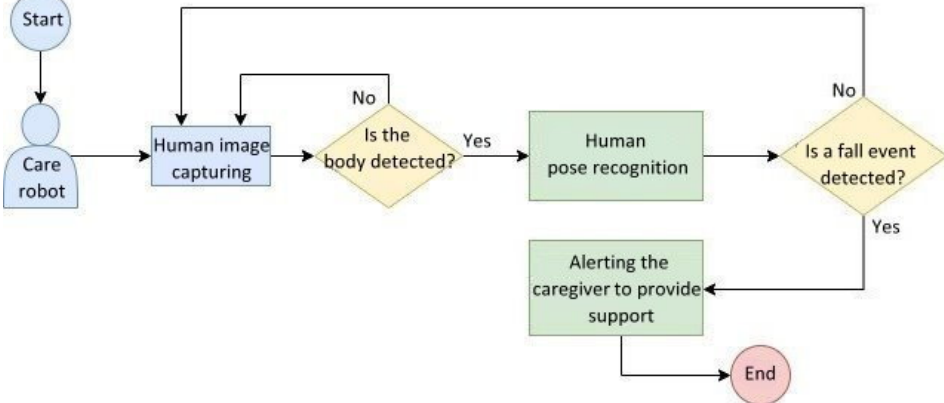
Figure 17. Behavioral flowchart of the human pose recognition system embedded in care robots.